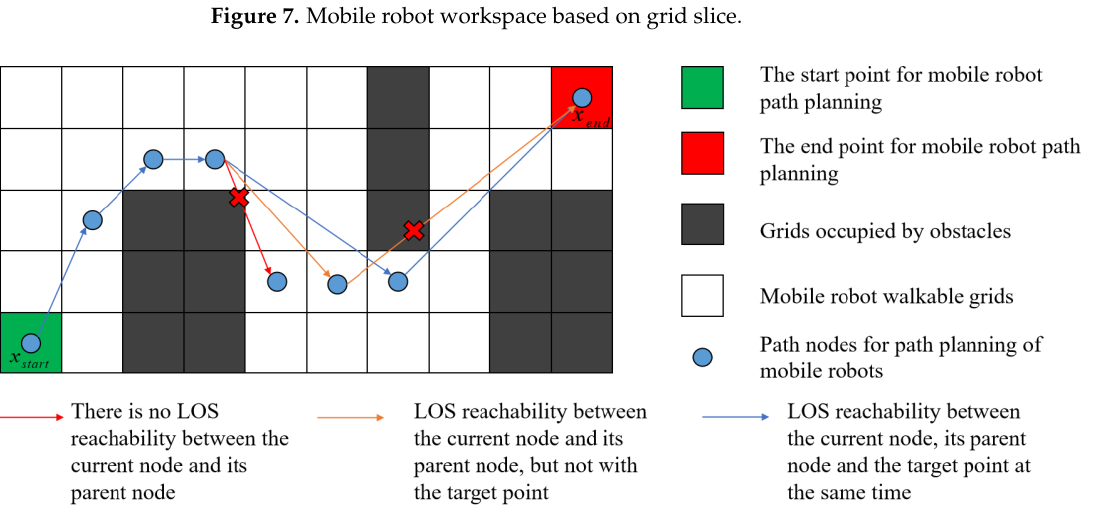
Figure 8. Determine if the current node needs to be retained by LOS detection.